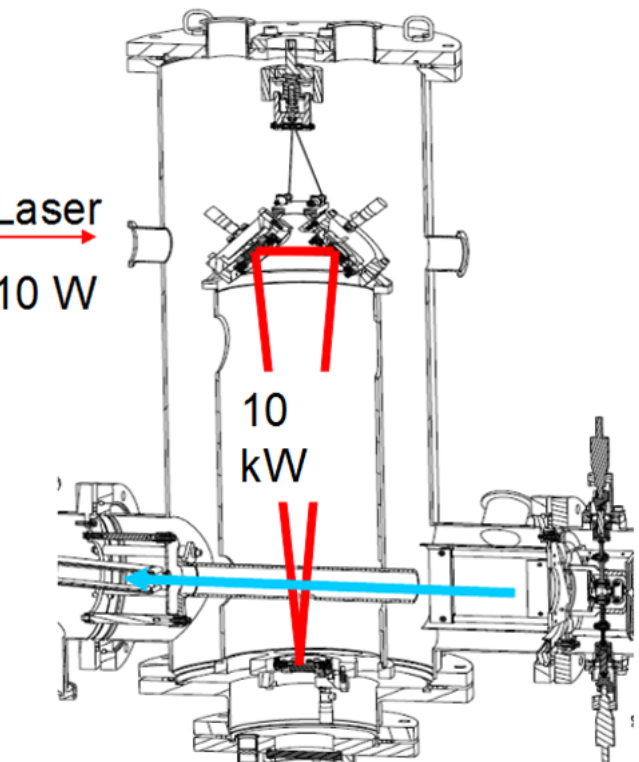
Figure 1. View of the experimental set-up. The optical cavity is suspended inside the vacuum chamber so as to reduce its coupling to external vibrations. The triangular optical circuit is about 1 m long. The laser beam is injected into the cavity horizontally, and (unshown) photodiodes and/or powermeters can be set to measure transmitted and reflected intensities, respectively, to get a measurement of the cavity finesse and amplification factor. The intensity is multiplied by a factor of 1000 inside the cavity, with respect to the input laser power, which makes typically a 10 kW laser beam circulate between the mirrors, with only 10 W of input power. Before reaching the laser beam, the ions pass (right to left) through an adjustable diaphragm made of two vertical plates mounted on micrometer screws, so as to make a quantitative measurement possible of the detachment rate, for ions that actually cross the intracavity optical mode. The neutral beam produced continues straightforward to be either detected by an electron multiplier or visualized by a beam imager made of microchannel plates and a phosphor screen. The intensity of the residual anion beam can be monitored by subsequent diversion of the remaining ions by deflection plates towards a Faraday